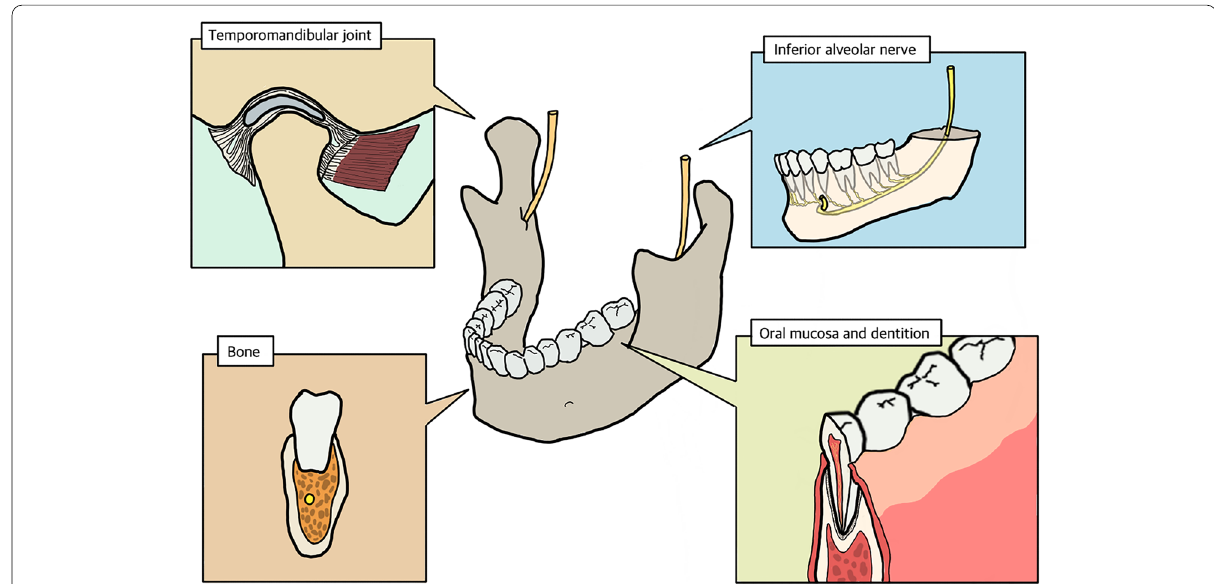
Fig. 1 Composite tissue anatomy of mandible, for composite tissue reconstruction of mandible, the anatomic component generally include temporomandibular joint, dentition, oral mucosa, inferior alveolar nerve, and parenchymal bone